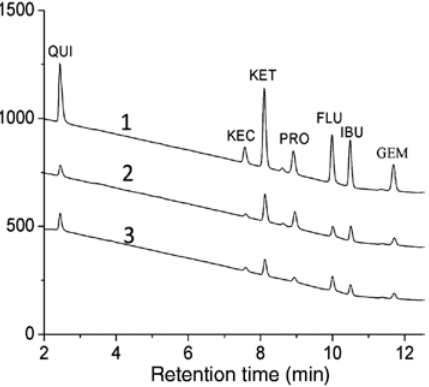
Figure 2: Sample clean-up capability of EME: chromatograms of the acceptor solutions after 20-min EME from 40 times diluted plasma (1) and after 10-min EME from 6 times diluted plasma (2), and the standard solution (3) (STD, 5 μ g/ml). Reprinted from Ref. Huang et al. 2015f, with permission © 2015 Elsevier